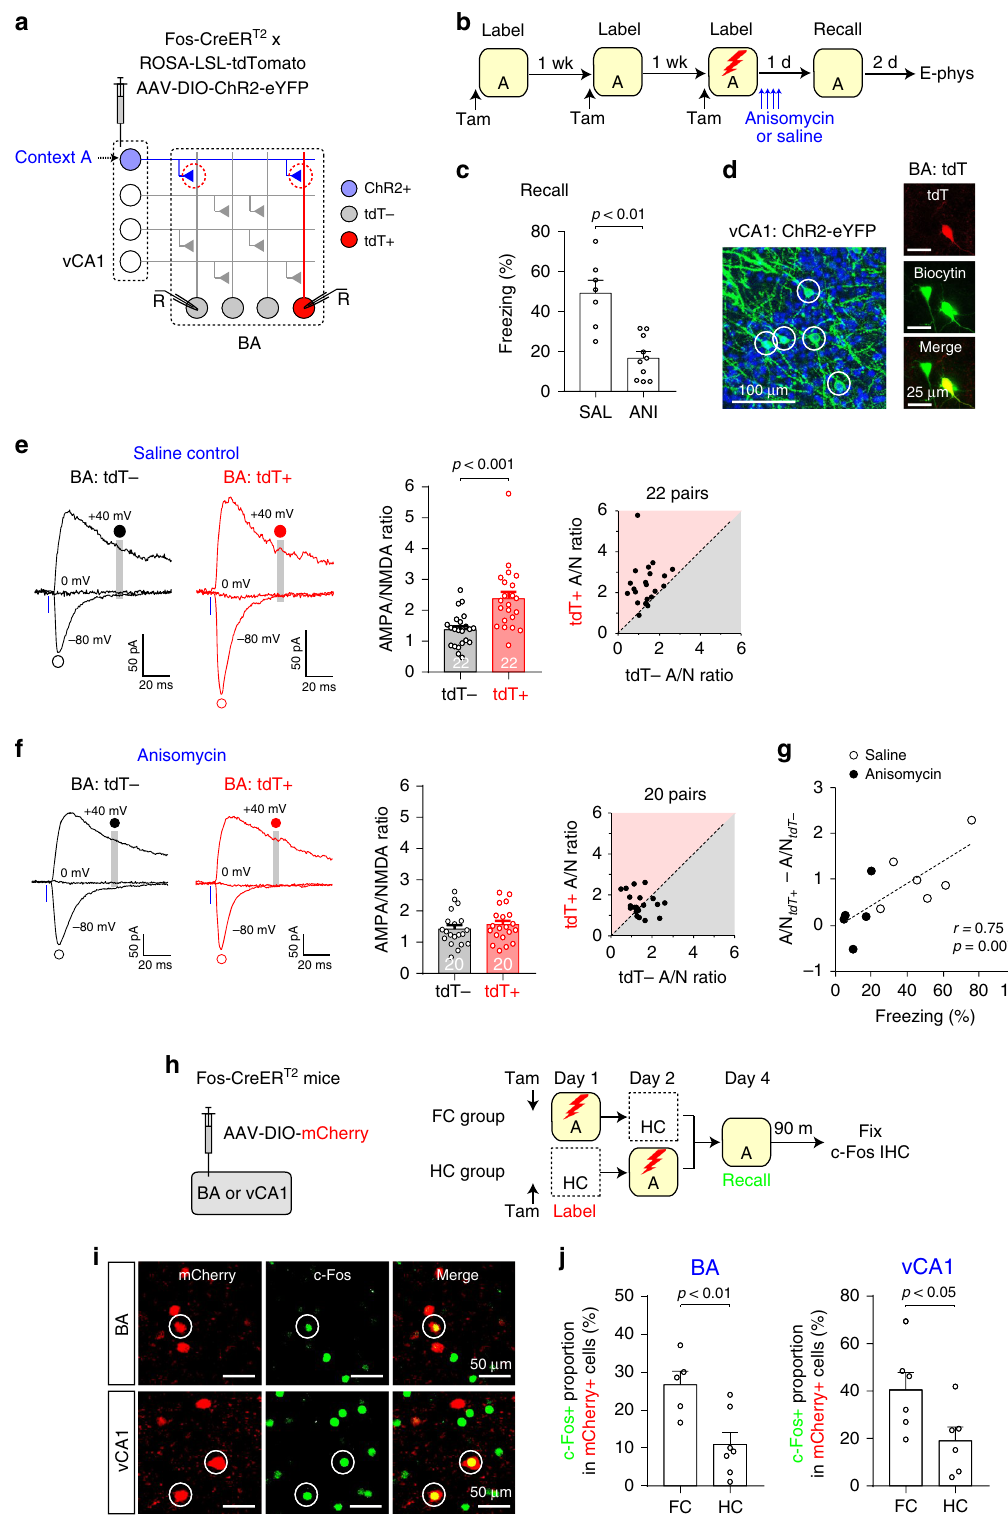
the home cages. As fear conditioning did not affect the excitability or intrinsic membrane properties of Context A vCA1 neurons (Supplementary Fig. 19), and anisomycin injection after fear learning prevented synaptic changes in the vCA1 – BA pathway (Fig. 6f), these results suggest that more vCA1 neurons active